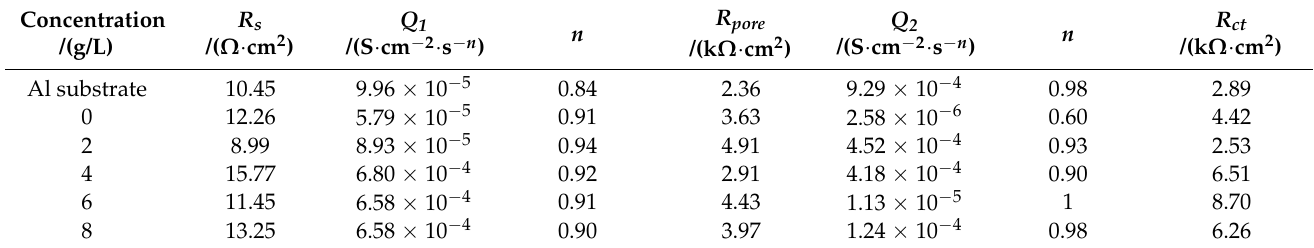
Figure 9. Equivalent circuit for fitting the EIS of the Cu-Ni-ZnO nanocomposite coatings. Table 3. Fitting results of the equivalent circuit of Cu-Ni-ZnO nanocomposite coatings with different (Cu, Ni)-ZnO additions.